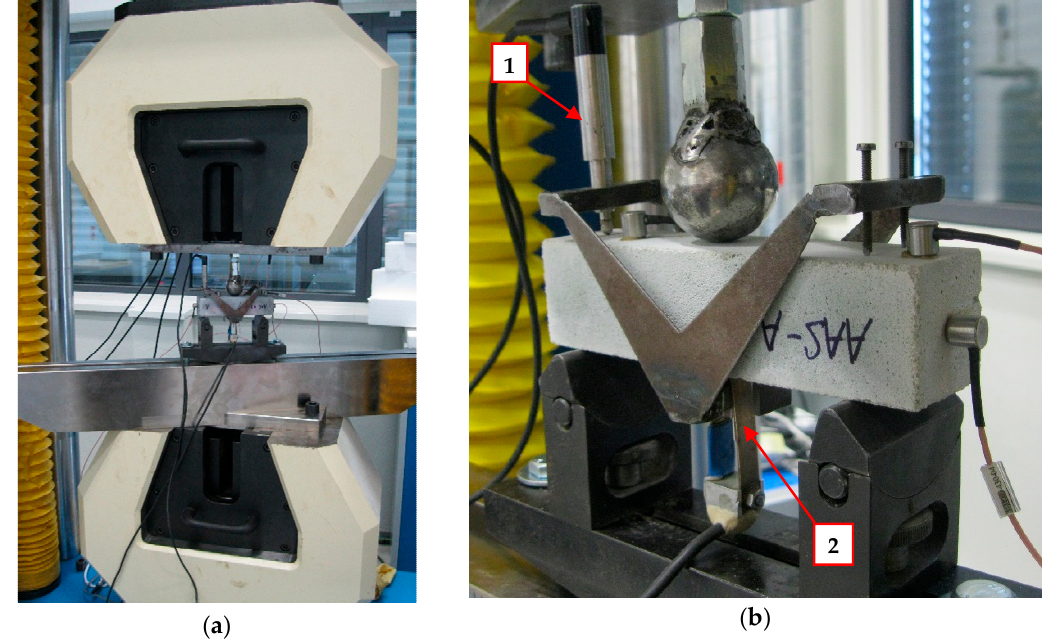
Figure 3. Fracture test configuration: ( a ) Overall view of the testing machine; ( b ) Detail of the positions of measuring sensors (1—deflection sensor fixed in the measurement frame, 2—extensometer).